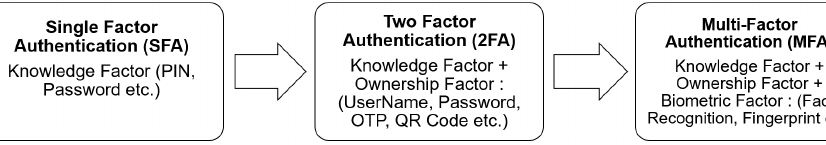
Figure 6. Evolution of MFA.